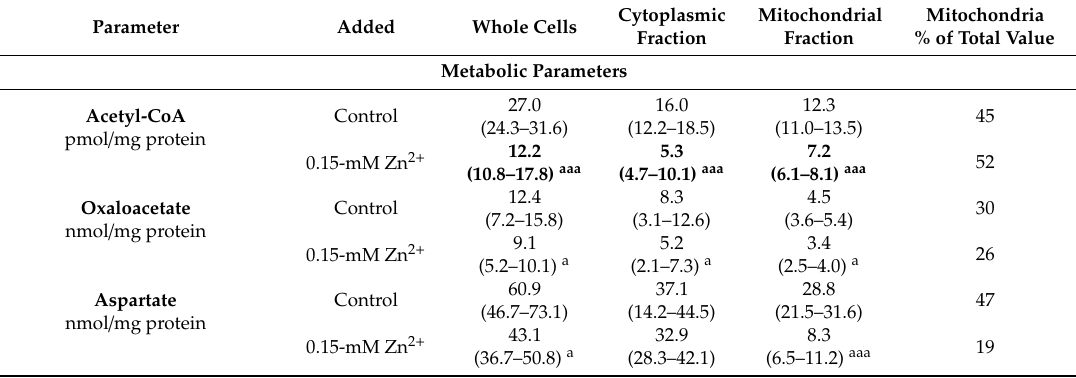
Table 4. Distribution of metabolite levels and enzyme activities in di ff erent subcellular fractions isolated from SN56 cells (chronic